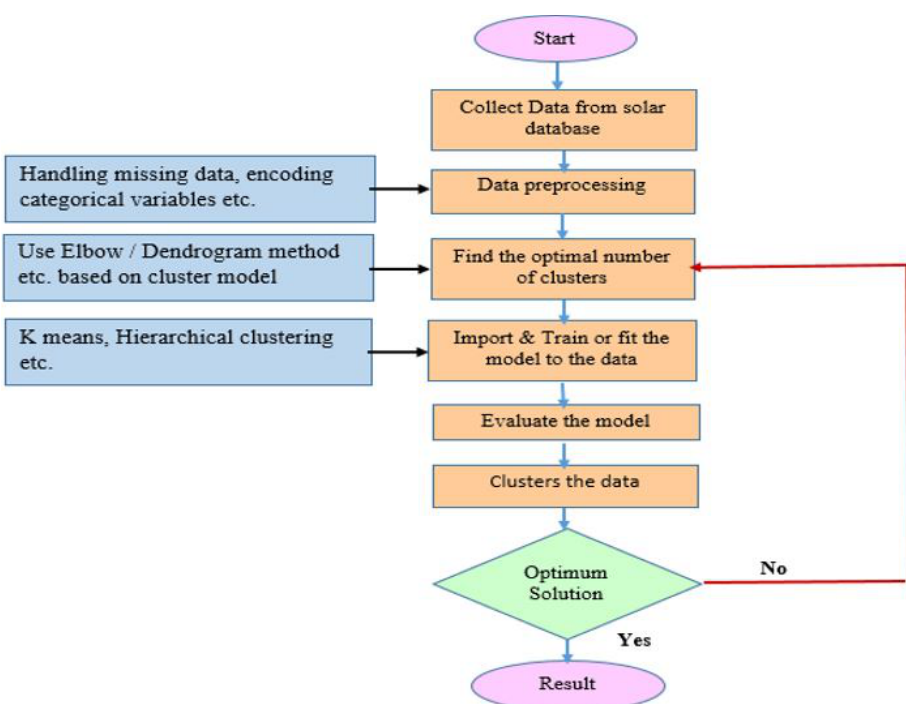
Figure 8. Flow chart for clustering based unsupervised